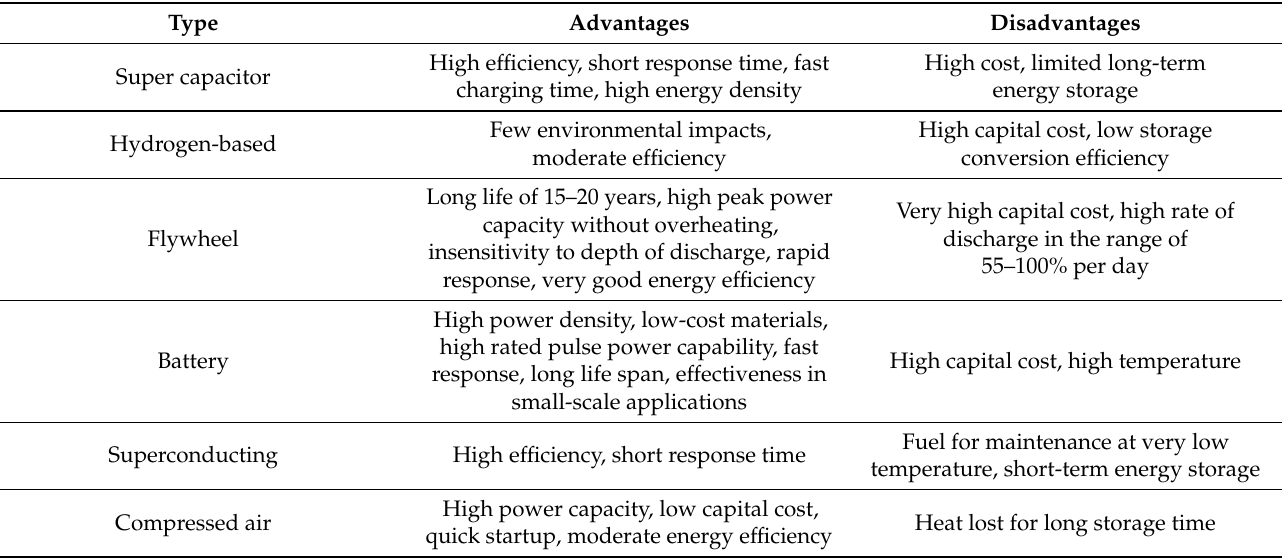
Table 2. The main energy storage systems with their principal advantages and disadvantages